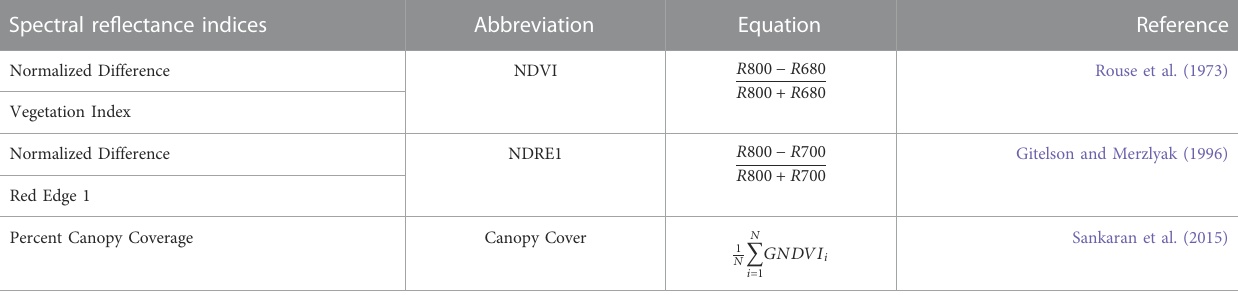
TABLE1Spectralre fl ectanceindicesimplemented.The fi rstcolumnprovidesthenameofthespectralindices,thesecondoneitsabbreviation,thethirdshowsthe equation used for computing each index, and the last one indicates the reference for each